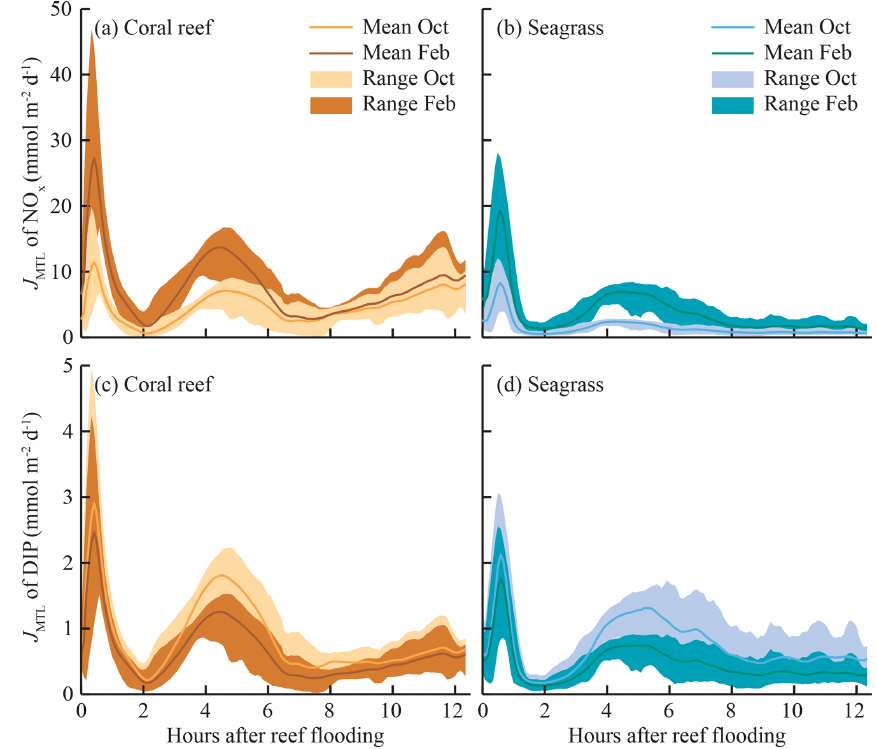
Figure 6. Tidal phase-averaged mass-transfer-limited uptake rates of J MTL for (a, b) NO x and (c, d) DIP in both coral- and seagrass- dominated zones over a full spring–neap cycle. Phase-averages are the mean of all measurements occurring at the same point in the tidal cycle (i.e., mean of all J MTL at high tide). Shaded areas of J MTL indicate the range where maximum values approximate uptake during spring tides and minimum values during neap tides. Estimates of J MTL were calculated using tidal phase-averaged nutrient concentrations from October and February field experiments (Fig. 3) and mass-transfer velocity S (Fig. 5e,